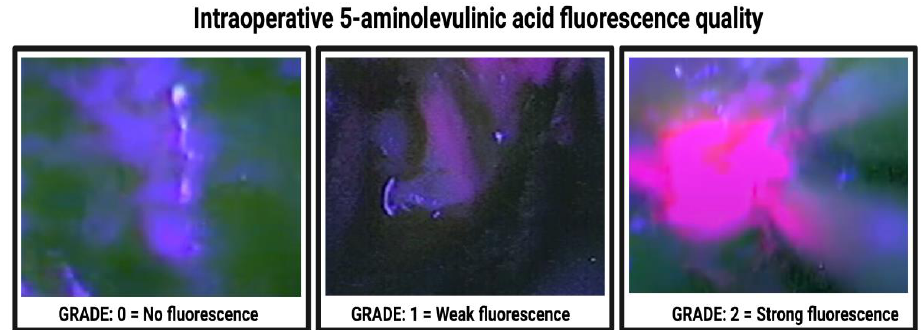
Figure 2. Classification system of 5-ALA fluorescence quality grading.